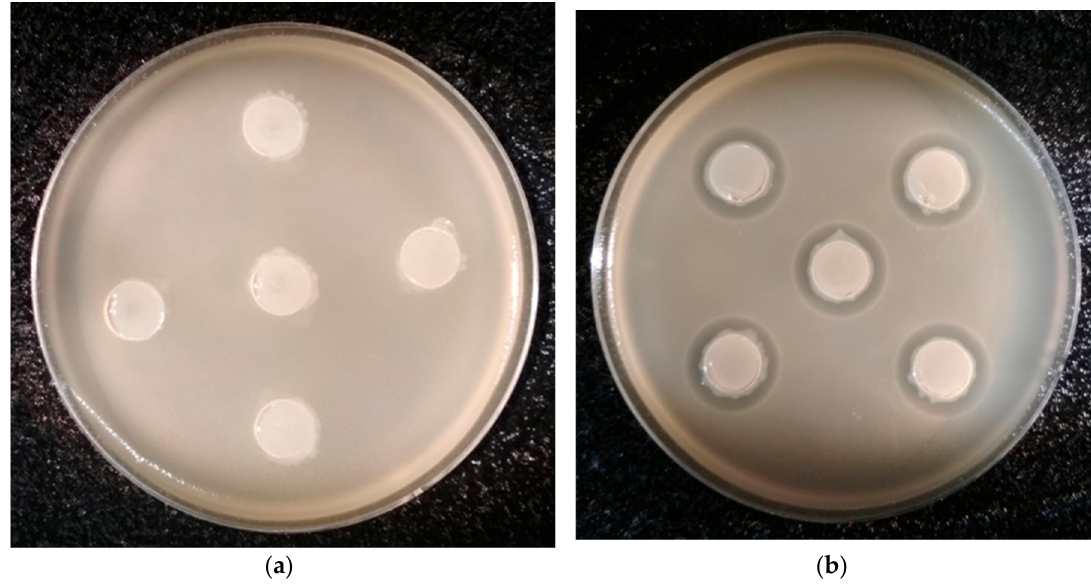
Figure 2. Interactions between M. melolontha midgut isolates and nematode bacteria in a modified agar well diffusion test. ( a ) Isolate incapable of inhibition of the growth of EPB. ( b ) MMC3 L3 04 isolate showing antagonistic activity against X. kozodoii. Table 2. Antagonistic activities of selected M. melolontha midgut isolates against five EPB strains that were shown by modified agar well diffusion tests. Strain